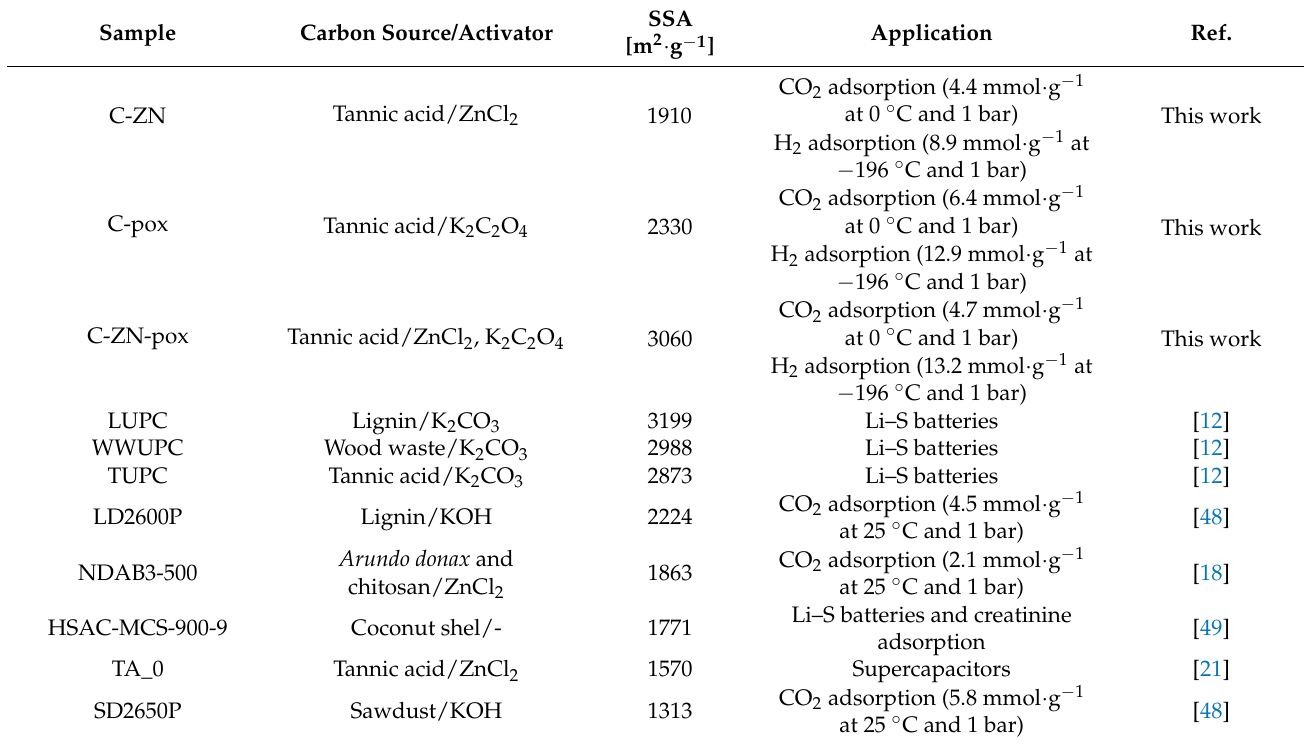
Table 4. Comparison of biomass-derived activated carbons obtained via mechanochemically-assisted